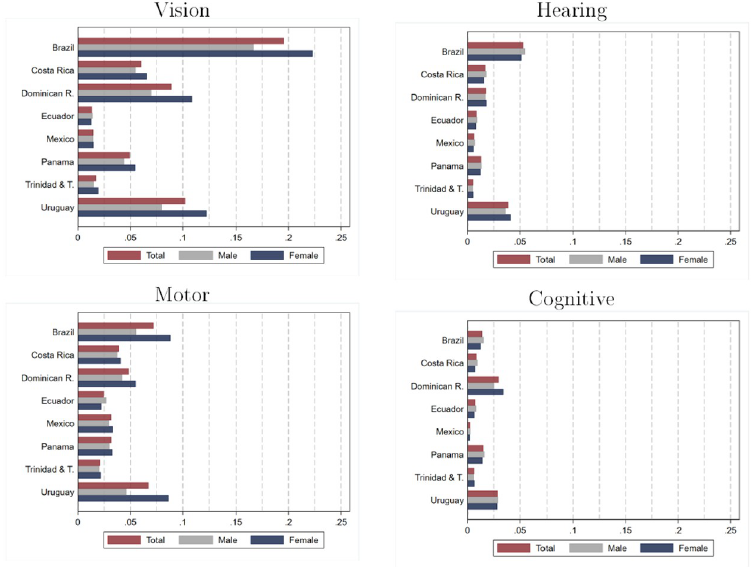
Fig 3. Prevalence of disability: Estimates by type, country and sex. Source: authors’ estimations based on data provided by [10] from censuses collected by National Statistics Offices in each country. Estimates for Brazil, Dominican Republic, Ecuador, Mexico, and Panama refer to the year 2010. Estimates for Costa Rica, Trinidad and Tobago, and Uruguay refer to the year 2011. Estimates consider individuals aged 3 years and older.